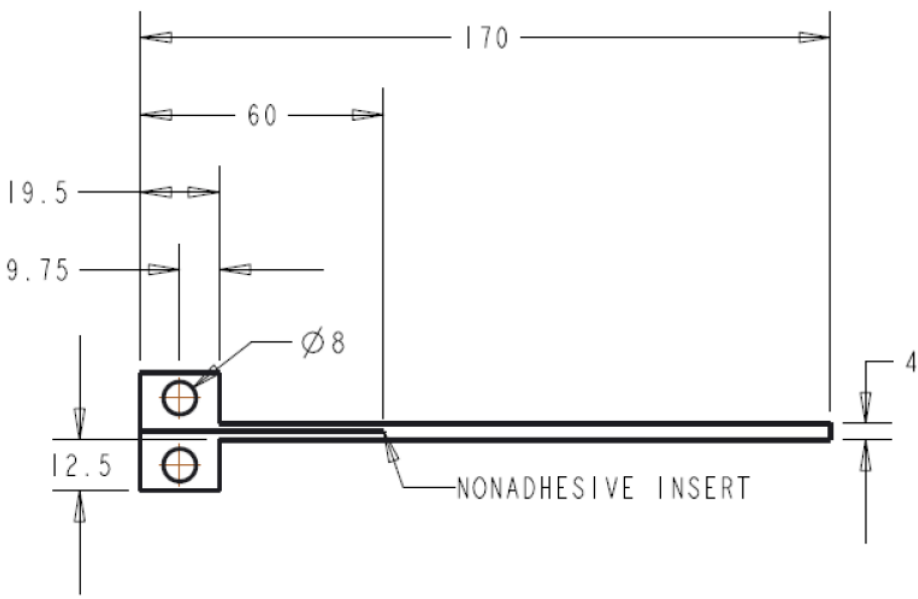
Figure 2. Exact dimensions of the DCB specimen (in mm).